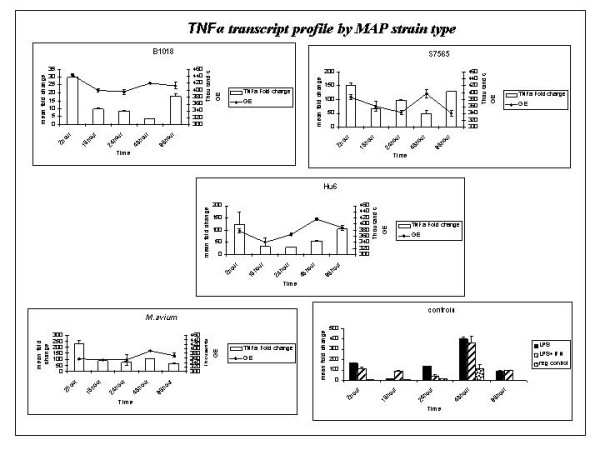
TNFα mRNA expressed by MDM cells exposed to MAP over time was measured by Real time RT PCR and fold change in gene expression relative to β actin was calculated by 2-ΔΔCT method. Mean fold change in gene expression is plotted on Y-axis (note that the Y1-axis scales have been optimized for magnitude of IL-10 expression for each strain). Intracellular bacterial numbers based on the amplification of hsp65 were calculated based on the genome size of MAP and represented as genome equivalents (GE) on second Y-axis. MDMs stimulated with B1018 expressed lower levels of TNFα mRNA relative to other cell stimulations.